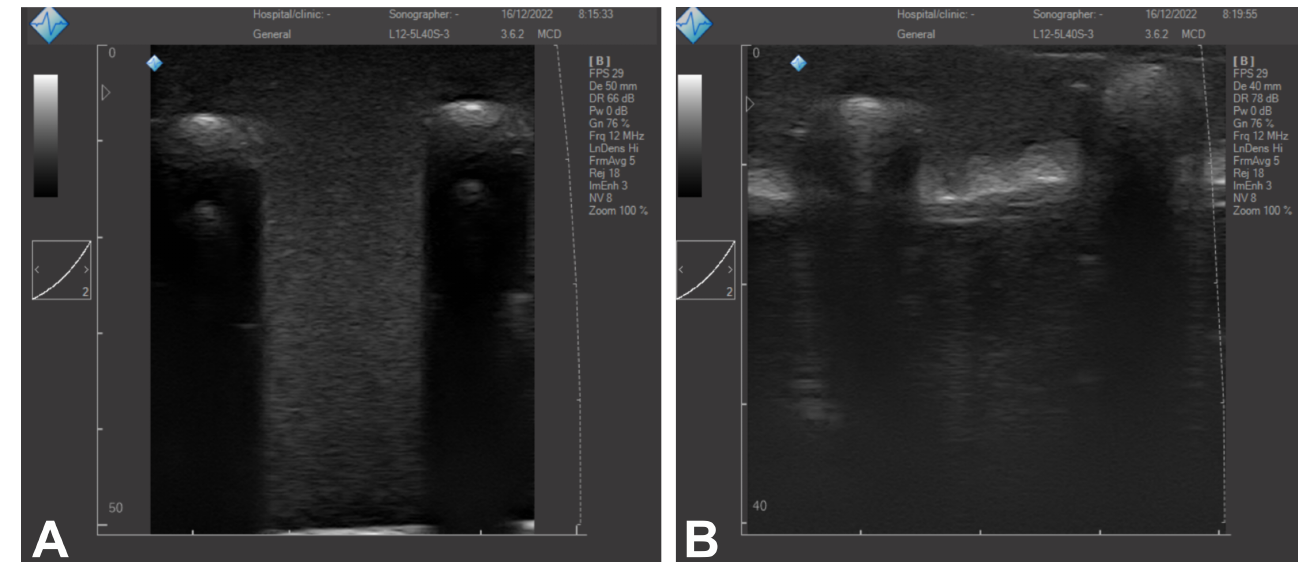
Figure 4. US image of the fabricated PVA-C phantoms including the ribs without ( A ) and with ( B ) mimicked